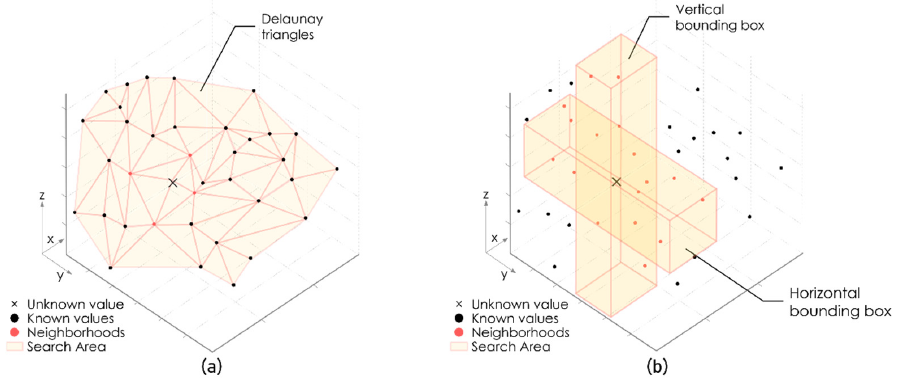
Figure 3. 3D search neighborhoods: ( a ) Constrained Delaunay triangle ‐ based approach [31]; ( b ) Two search ‐ grid surround boxes ‐ based approach [9].